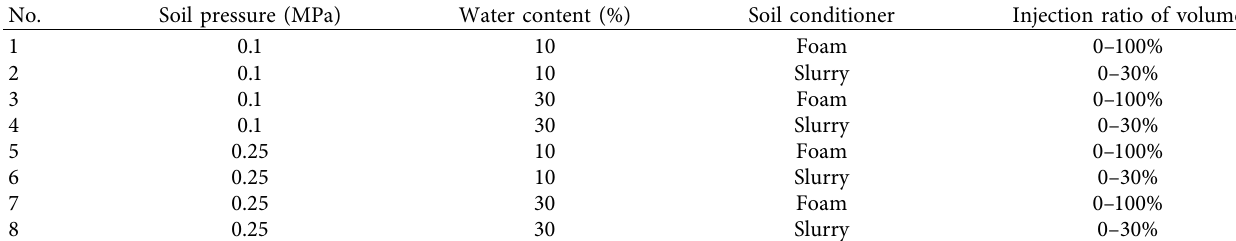
Figure 17: Effect of addition rate of CMC on funnel viscosity. Table 5: Testing conditions for soil conditioning.